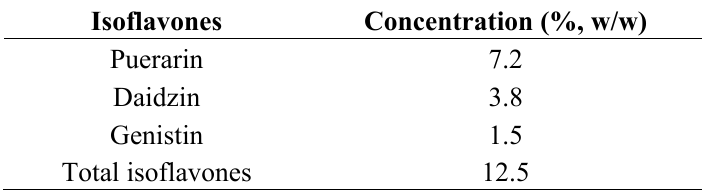
Table 1. Composition of puerarin and other isoflavones from P. lobata extracts.